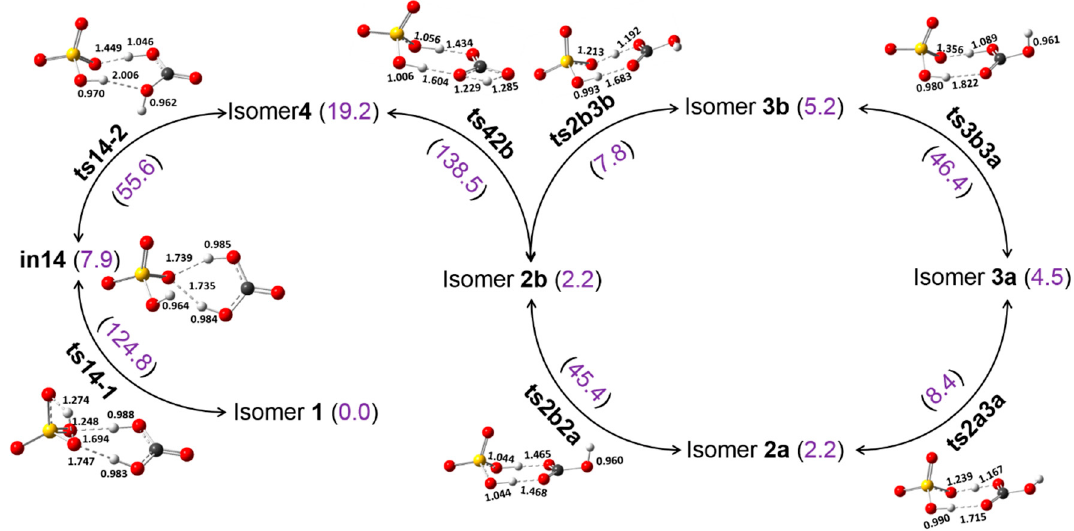
Figure 2. Calculated isomerization pathways between the different isomers of [H 2 CO 3 ·HSO 4 ] – . The optimized structures of transition states are provided, and the energy barriers are in kJ/mol in parenthesis.